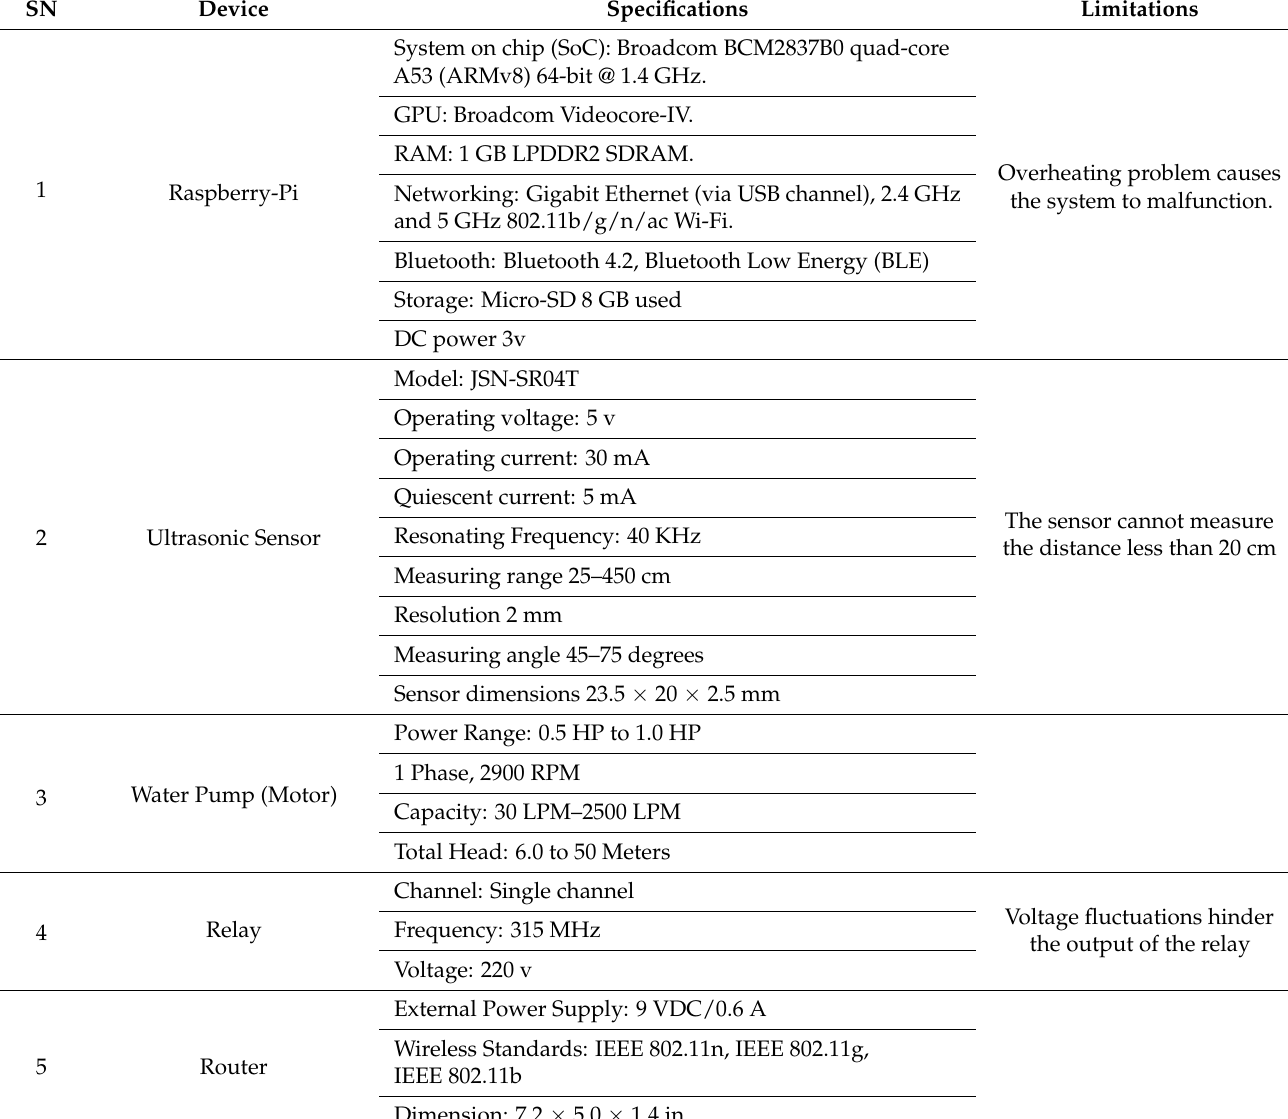
Table 3. Technical specifications and limitations of device used in the